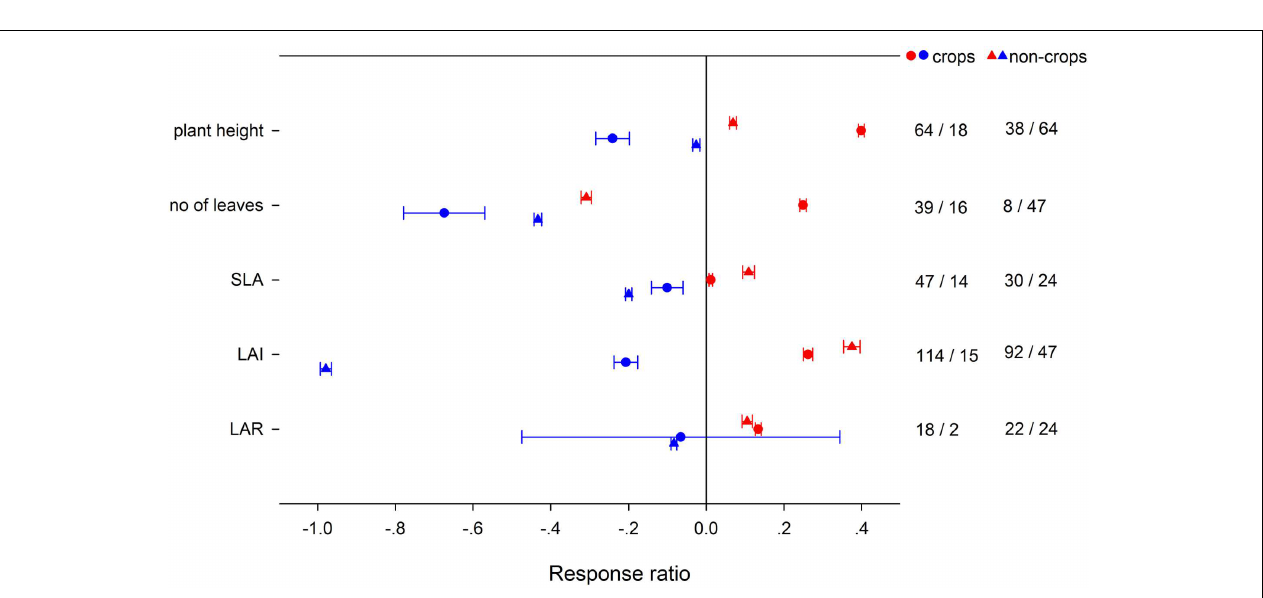
FIGURE 4 | Plant physiological responses to HNT (red) and LNT (blue) in crops (circles) and non-crops (triangles) species. Each data point represents the mean ± 95% CI. The number of observations for each variable is given on the right of the graph.